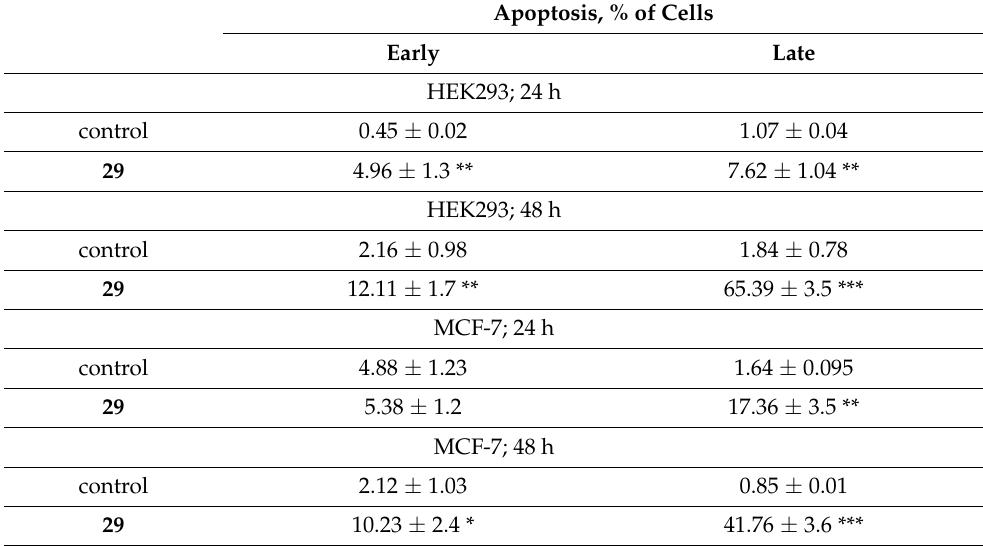
Figure 3. Cell cycle progression of HEK293, A549, MCF-7, and SHSY5Y cells upon compound 13 treatment. Data are expressed as mean ± S.E.M from three experiments, performed in triplicate. *— p < 0.05 vs. corresponding control (untreated) cells (Wilcoxon t -test). Table 4. Apoptosis events in HEK293 and MCF-7 cells upon compound 29